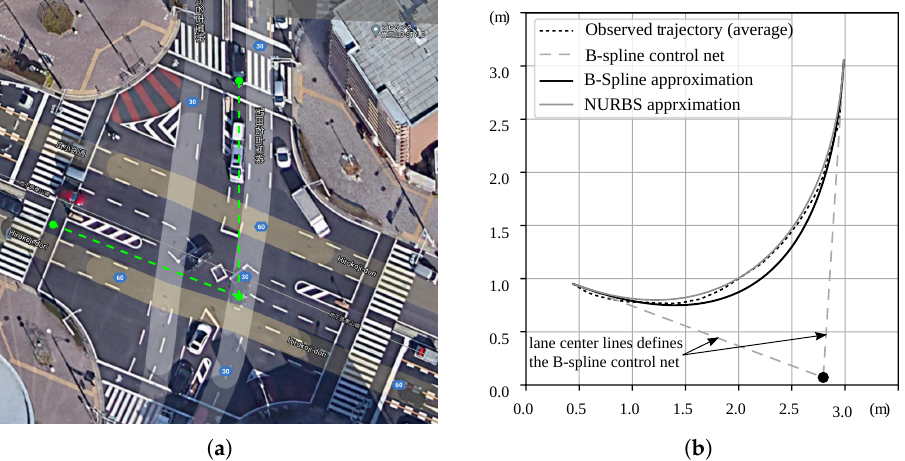
Figure 2. Comparison of the average of the trajectory observations by Alhajyaseen et al. and our B-spline and NURBS approximations. The source of the background image of Suemori Dori 2 intersection in Nagoya is Google Maps. ( a ) Green color points and dashed lines shows the control net of the third-order B-spline for approximating vehicle trajectories. ( b ) Comparison of third-order B-Spline and NURBS approximations with the observations by Alhajyaseen et al.